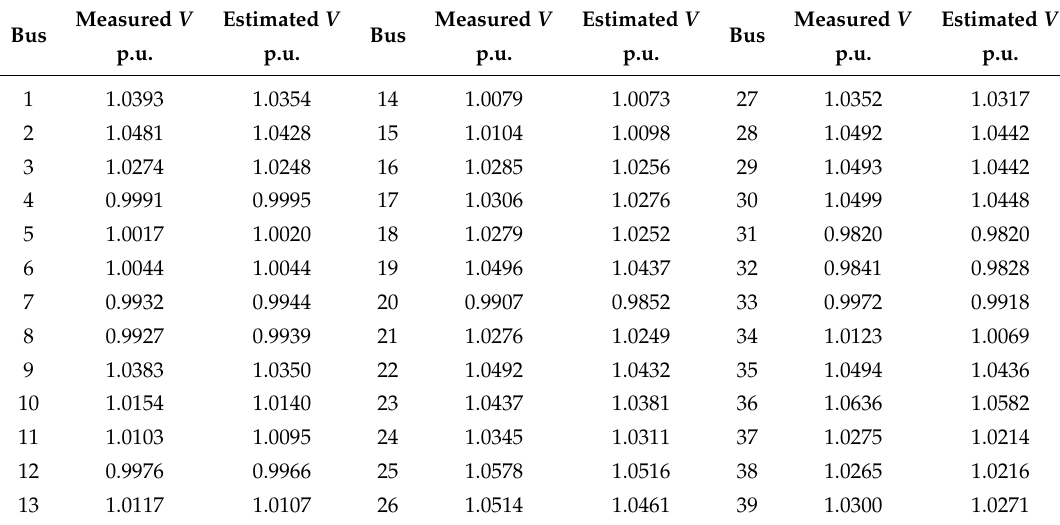
Table A3. Comparison of Measurements and their Estimations of IEEE 39 Test System for the Summer Case after the First Step of the Presented Method using Base Model Calculated for 20 ◦ C.